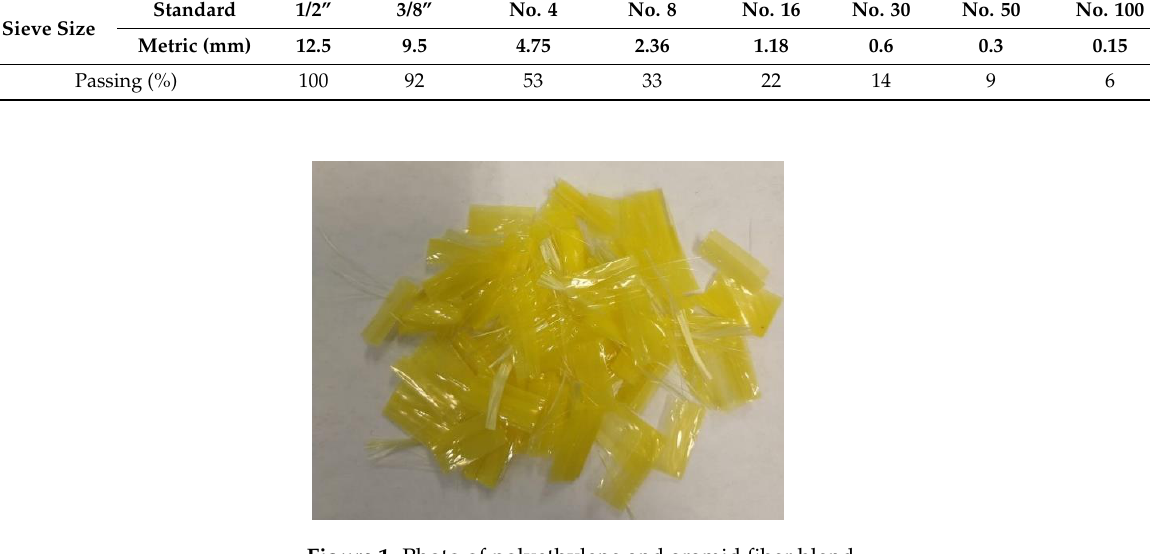
Figure 1. Photo of polyethylene and aramid fiber blend.